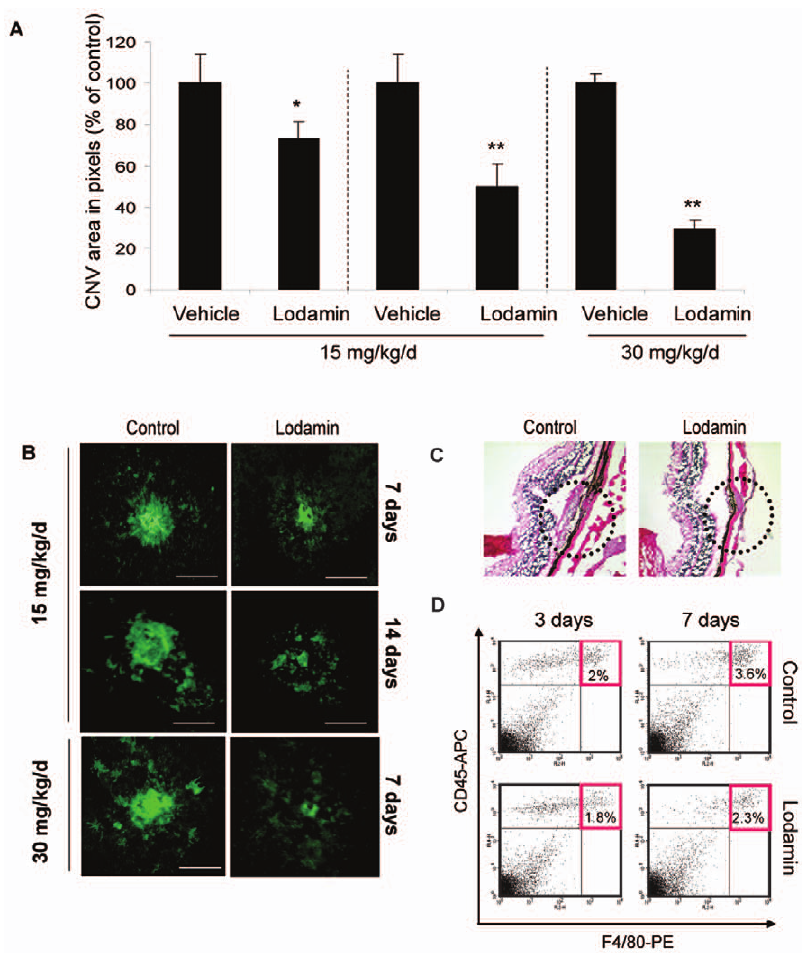
Figure 3. Oral treatment of Lodamin reduces CNV progression. ( A ) CNV lesion size of Lodamin-treated mice compared to controls. A dose of 15 mg/kg/day was administered for 7 or 14 days and a dose of 30 mg/kg/day was administered for 7 days. CNV lesions in choroidal flat mounts were evaluated after staining of blood vessels using isolectin-IB4 conjugated with Alexa Fluor 488. Data are presented as percent of blood vessel area in choroidal flat mounts (pixels) of treatment per controls. Data are expressed as mean 6 SEM, (U-test, * P , 0.05, ** P , 0.005, n=10). (B) Representative images of CNV lesions stained with a lectin-FITC in flat mount of mouse choroids. Bar=20 m m. ( C ) H&E stained histological side sections of CNV site in Lodamin treated or untreated mice. Substantial differences in fibrous tissues thickness and choroidal vessel invasion to CNV site are detected, Bars=50 m m ( D ) FACS analysis of single-cell suspension originated from retinas after 3 and 7 days of oral Lodamin treatment. Quantification of macrophage infiltration in mouse retinas originated from Lodamin treated (30 mg/kg, daily, oral) or mice which were treated with equivalent dose of vehicle. Macrophage population was detected as a double positive CD45 + and F4/80 + staining.